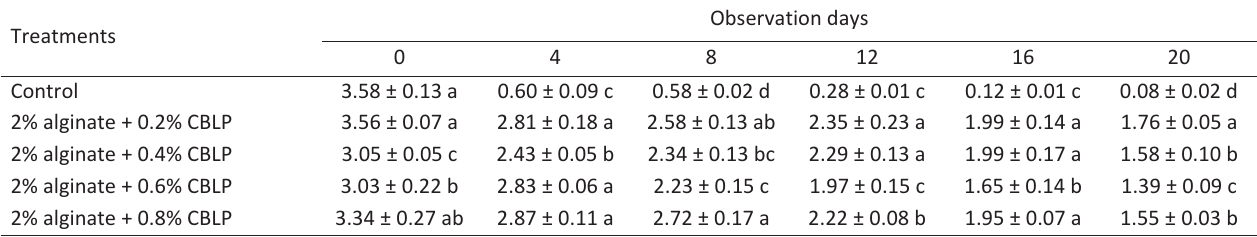
Table 1 ­ Result of firmness in kg/cm 2 of guava treated with alginate­based edible coating enriched with different concentration of Cyclea barbata leaves powder (CBLP)